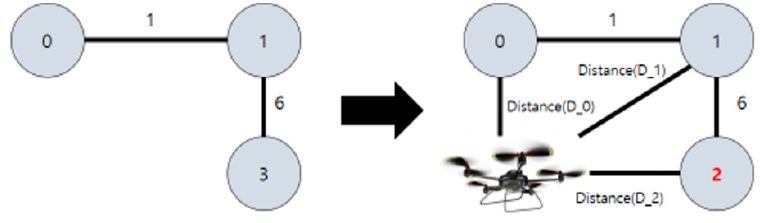
Figure 11. Proposed Algorithm (3).